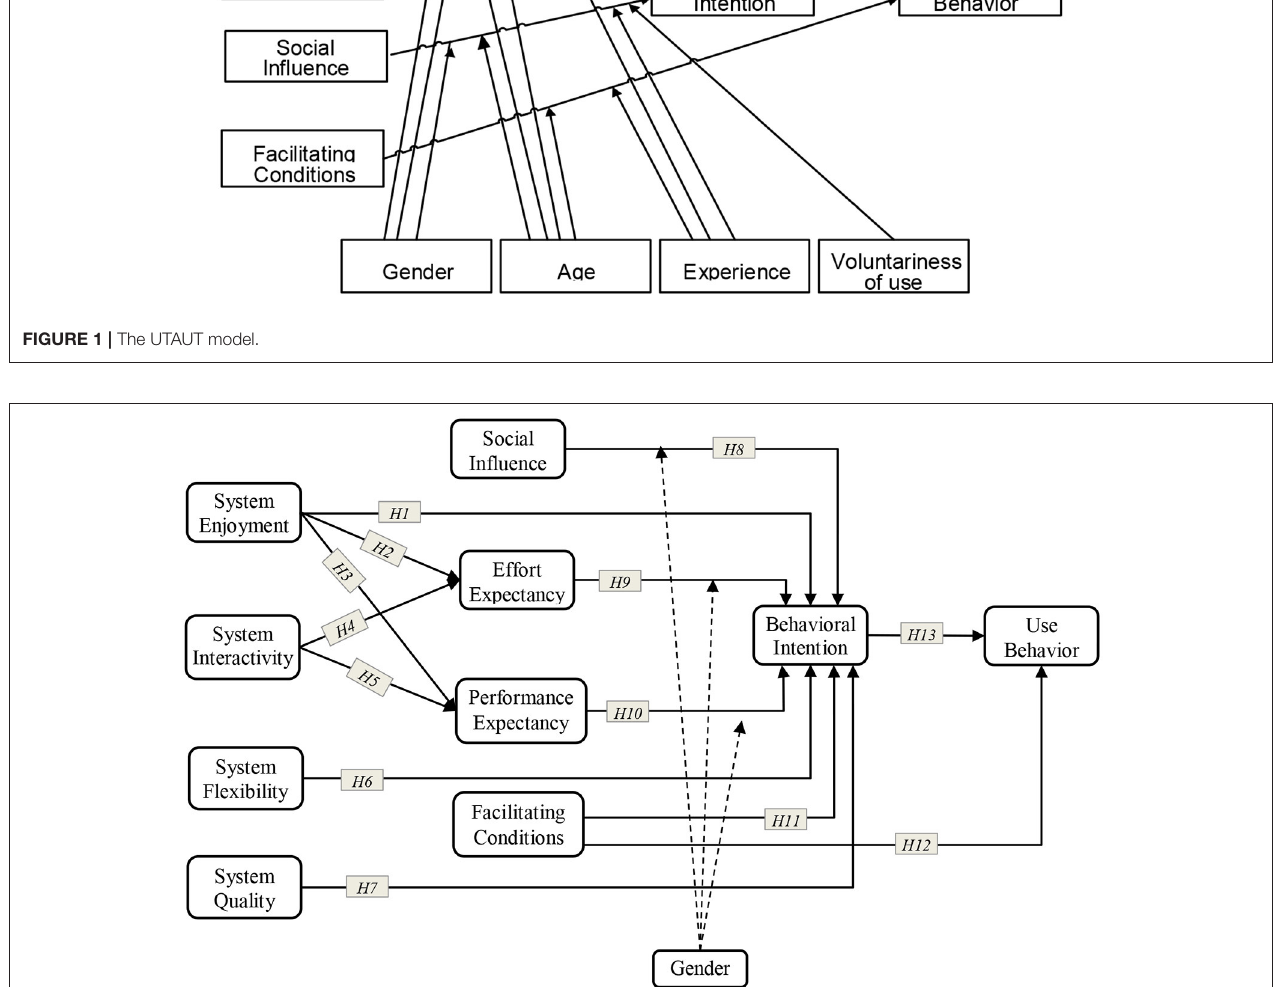
FIGURE 2 | The proposed